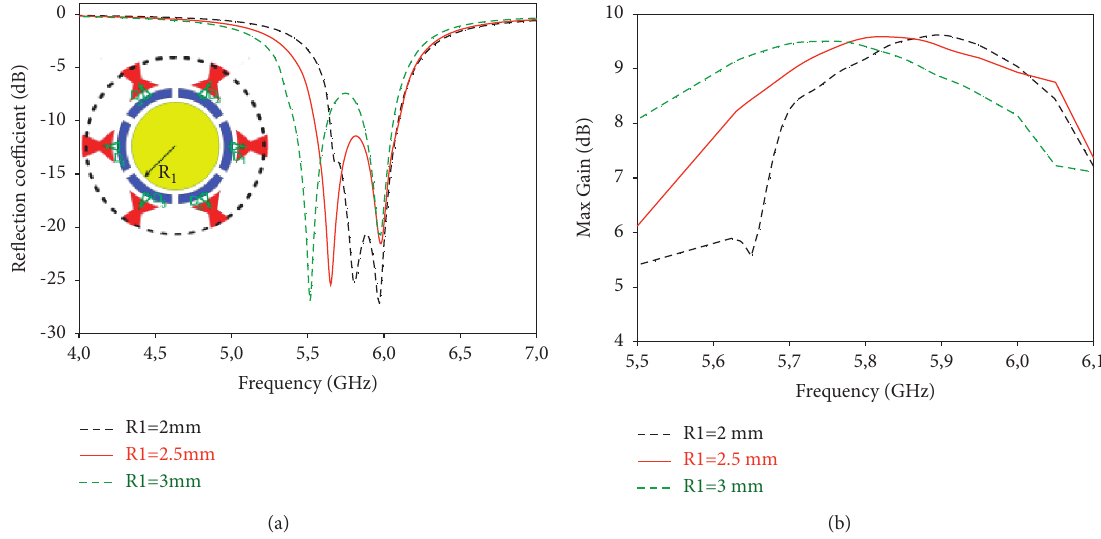
Figure 8: Reflection coefficient (a) and gain (b) for different radius (R1)